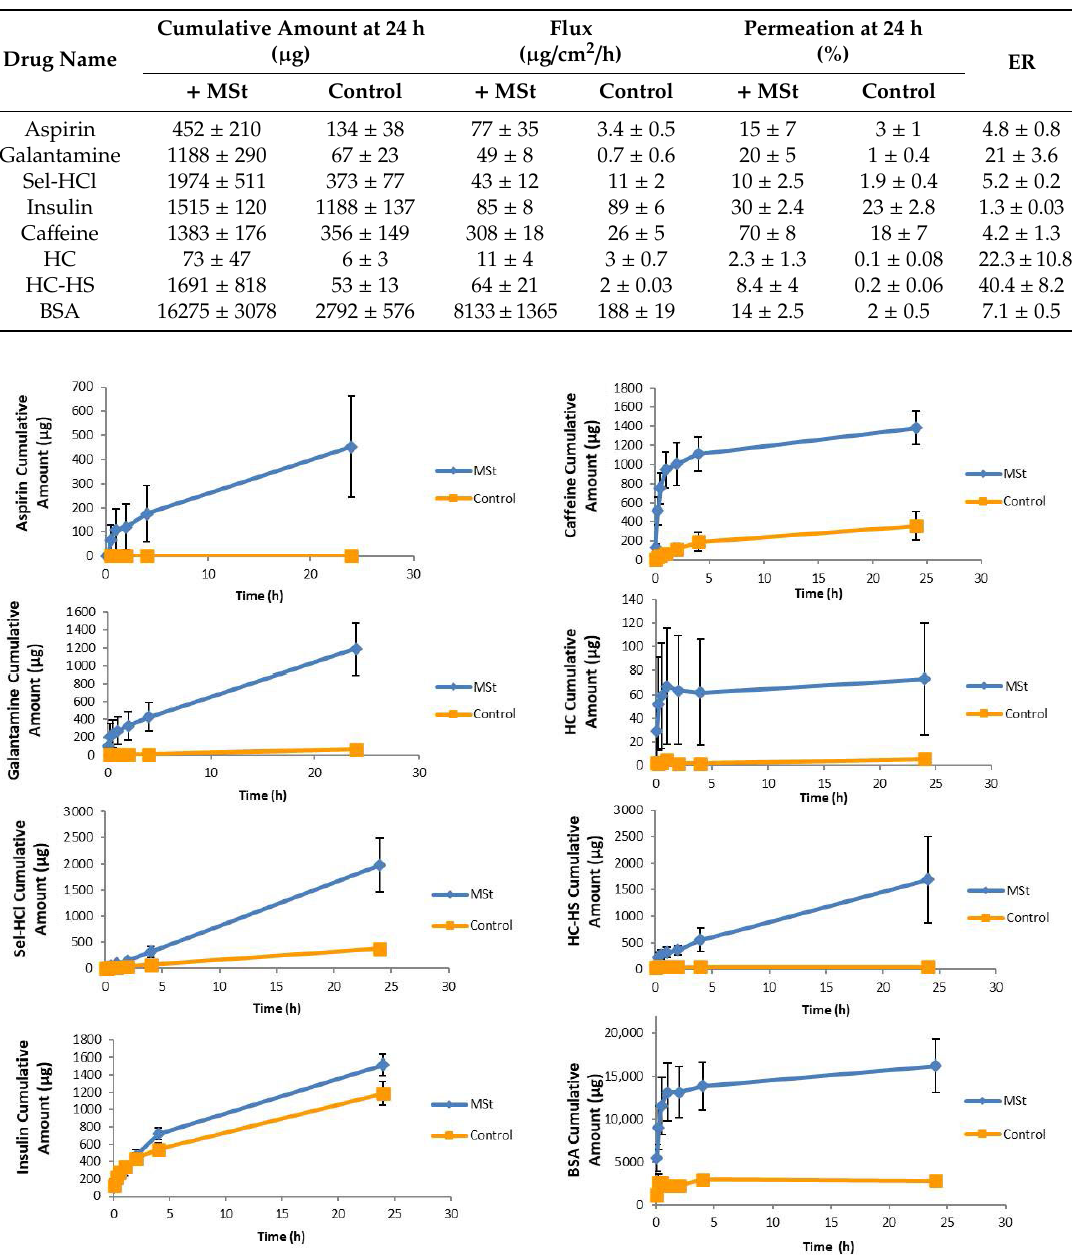
Table 4. Cumulative amount of molecules, permeated after 24 h through porcine skin (1.77 cm 2 ), flux, permeation percentage and enhancement rate (ER).